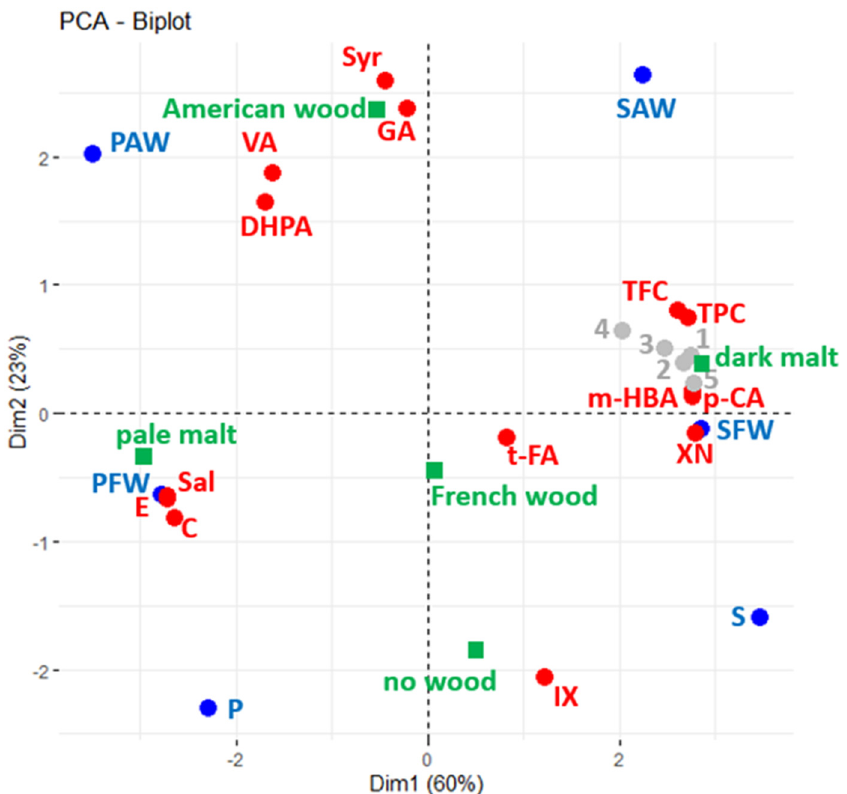
Figure 3. Principal Component Analysis (PCA) biplots of polyphenol composition (red) of beers (blue) used as active variables. Data from bioactivity assays (grey) used as passive supplementary variables (1 = FRAP, 2 = DPPH, 3 = antioxidant, 4 = anti-inflammatory, and 5 = antiproliferative). In green, the type of malt and wood origin are explored as supplementary factors.